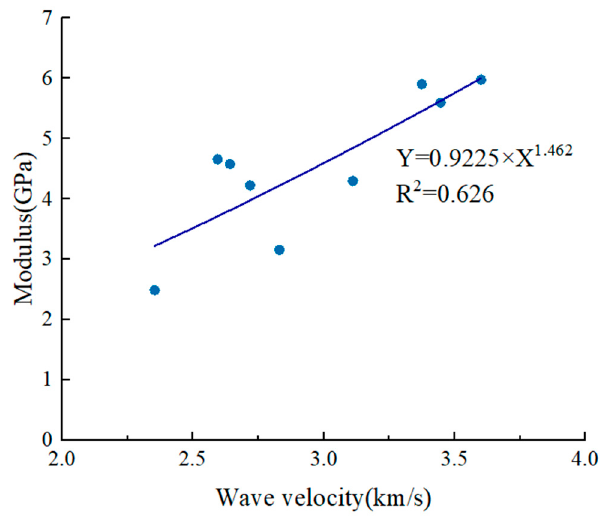
Figure 9. Relationship between modulus and wave velocity.